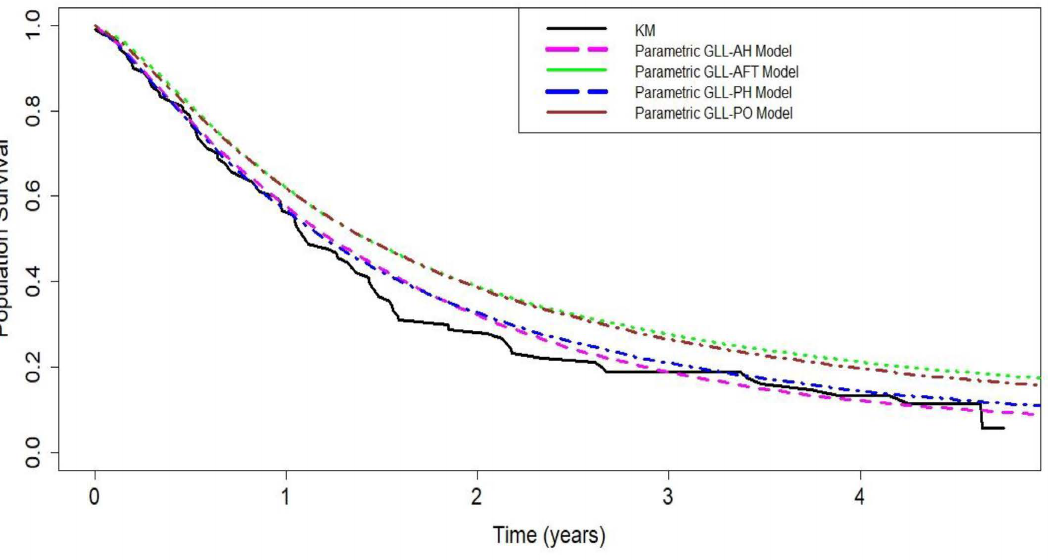
Figure 14. Kaplan–Meier and estimated survival plots for the competitive regression models with the GLL baseline distribution of the gastric cancer